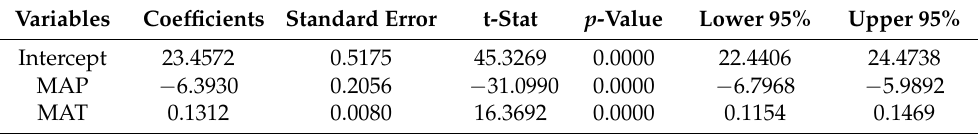
Table 5. The regression statistics results for the